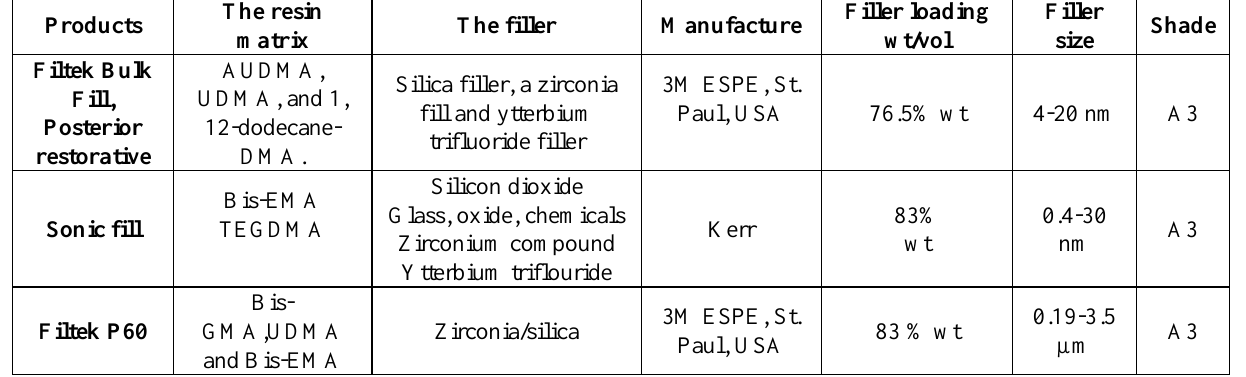
Table 1: Composition of the tested materials and drinks used in this study